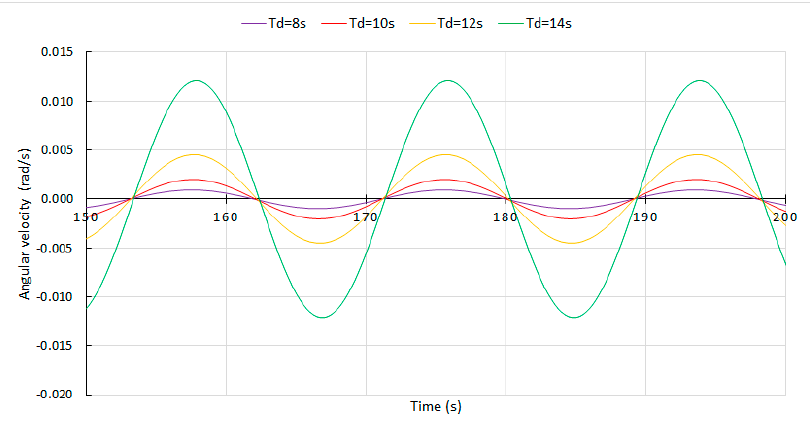
Figure 5. Rolling angular velocities reached by di ff erent ship loading conditions for Tw = 18 s. and waves) after the first 150–200 s under the influence of the waves, regardless of the a Tw = 12 s and where the ship has a Td = 9 s (yellow colour) is shown in Figure 6. Over this graph, the exponential limit curve (purple colour) is also plotted where it is deducted that, from 150 to 200 s onwards, a perfect coupling of the ship to the waves’ frequencies is registered, keeping the amplitude of the rolling angles constant over